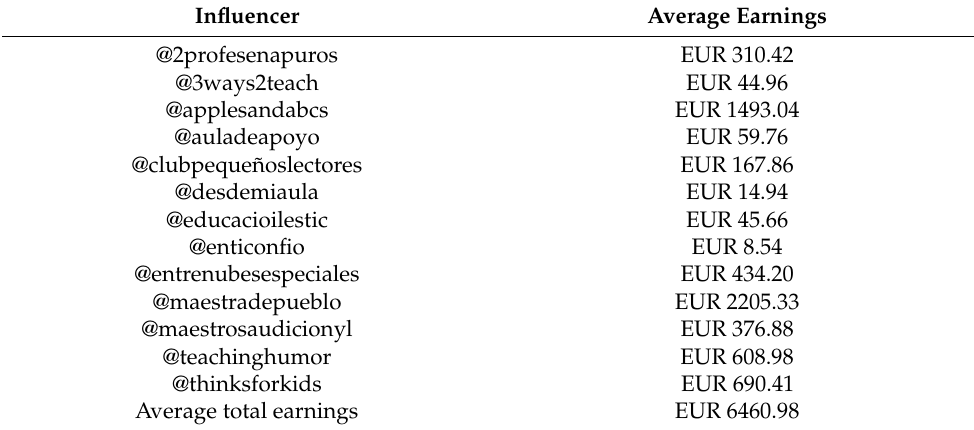
Table 7. Average earnings of influencers. Influencer Average